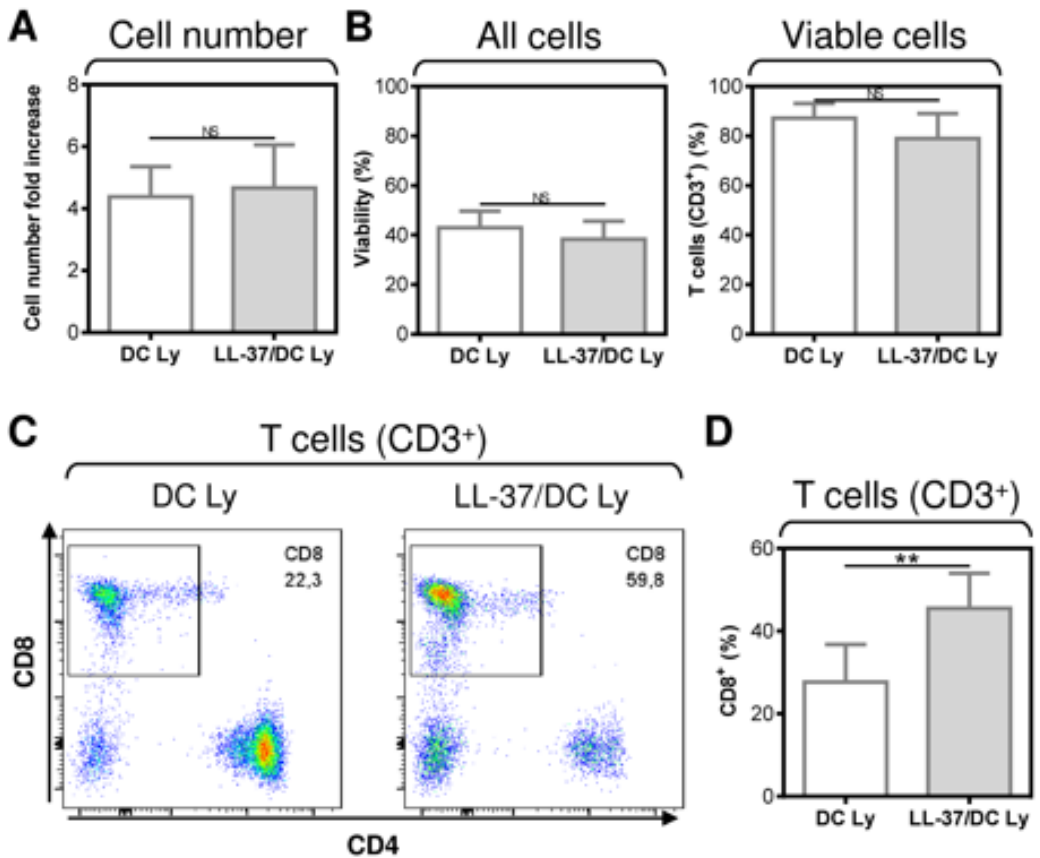
Figure 2. The application of LL-37 during DC production (differentiation, pulsation, and maturation) significantly enhanced CD8 + T cell enrichment of DC-stimulated autologous lymphocytes. ( A ) The cell number fold increase in the 14-day autologous lymphocytes stimulated with DCs (DC Ly), or DCs produced in the presence (differentiation, pulsation, and maturation) of LL-37 (LL-37/DC Ly). ( B – D ) The DC-stimulated and 14-day-cultured autologous lymphocytes were analyzed by flow cytometry. The gating strategy was as in Figure 1B, and cell viability ( B , left panel), the frequency of T cells (CD3 + ) ( B , right panel), and their CD8 + population ( C , D ) were determined. In ( A , B , D ), mean + SEM and significances of differences between the group of DC Ly and LL-37/DC Ly samples are indicated ( NS p > 0.05, ** p < 0.01; n = eight donors; paired two-tailed Student’s t -test).